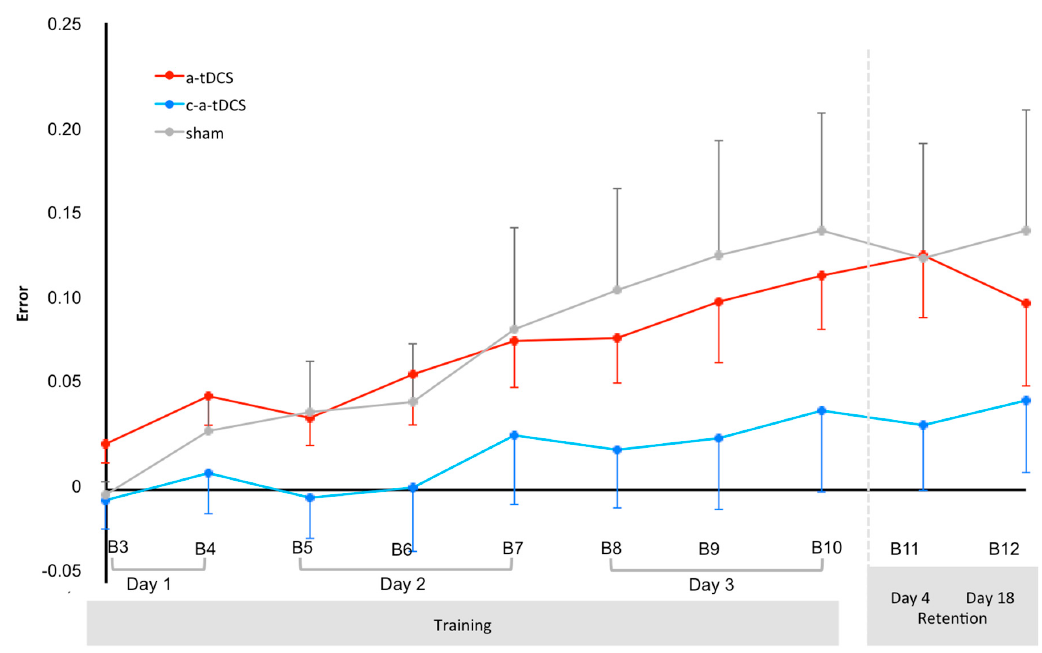
Figure 4. Evolution of mean (and one SEM) error over time (blocks—B) for each of the 3 groups. B3, B6 and B9 represent online tDCS. B3, B6 and B9 represent online tDCS. B4, B7 and B10 represent immediate offline. B5 and B8 represent delayed offline.